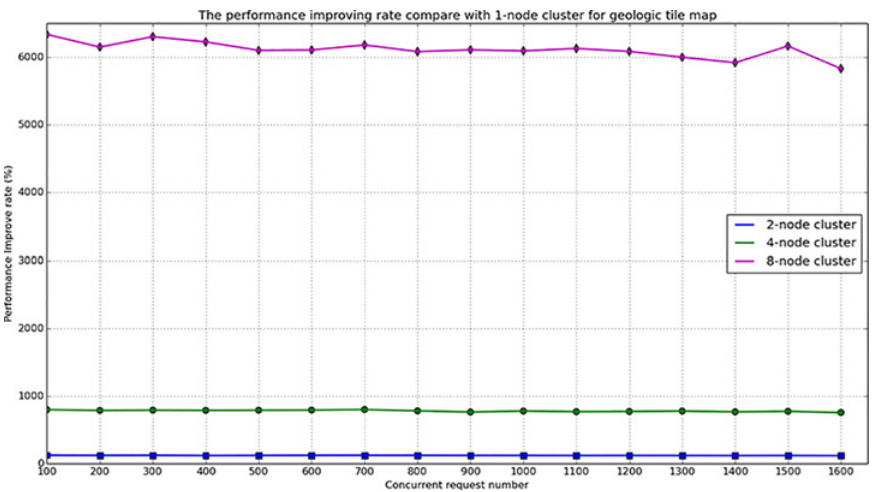
Fig 19. Performance improving rate of tile map service compared with 1-node cluster.